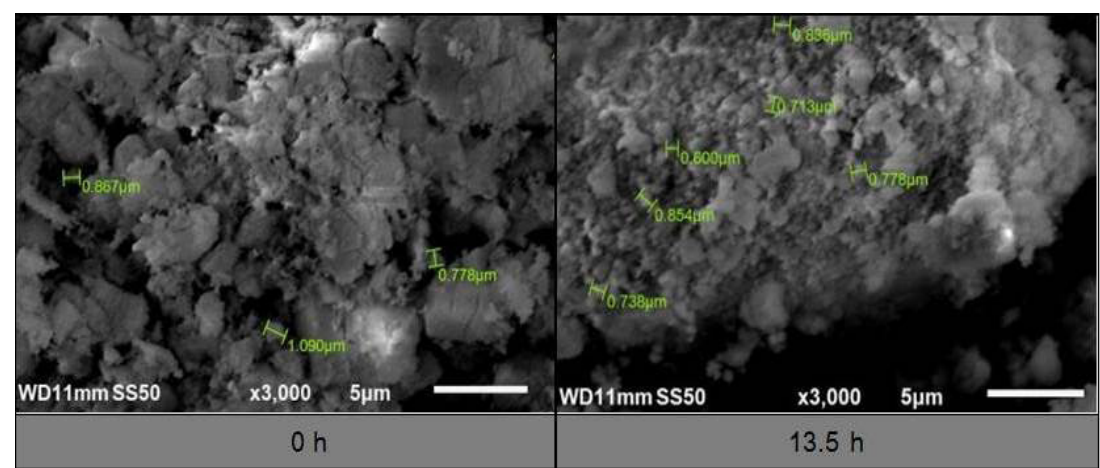
Fig. 8 SEM images of Nd